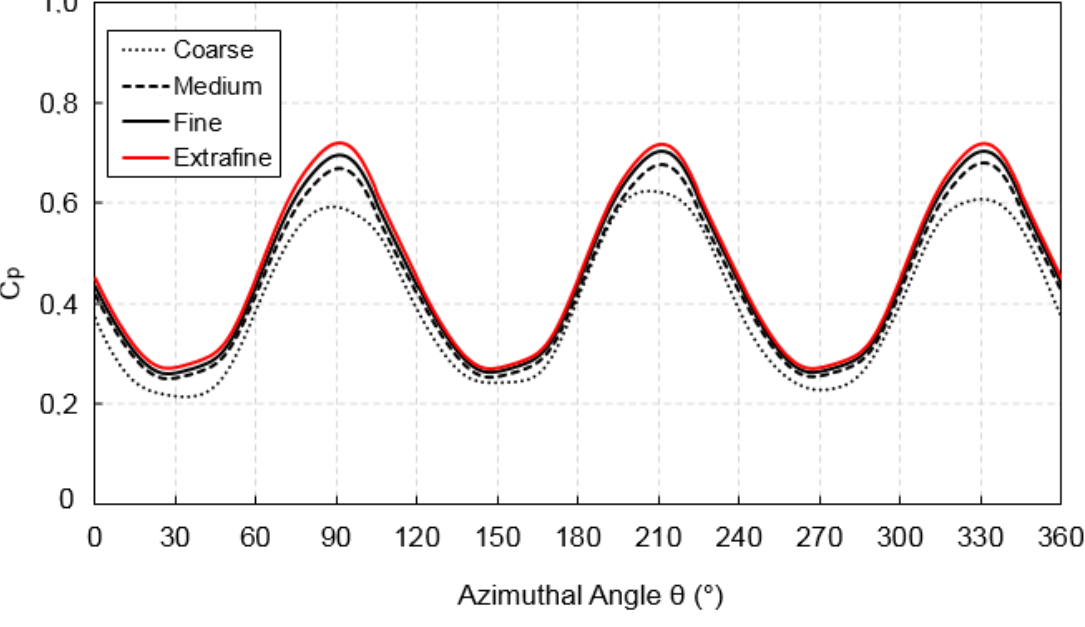
Figure 5. Grid convergence study for λ = 2.